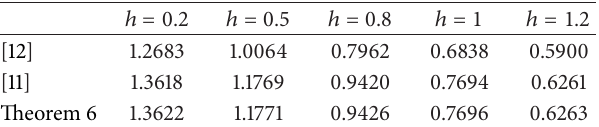
Table 1: Comparison of the upper bounds of the decay rate for different delays.